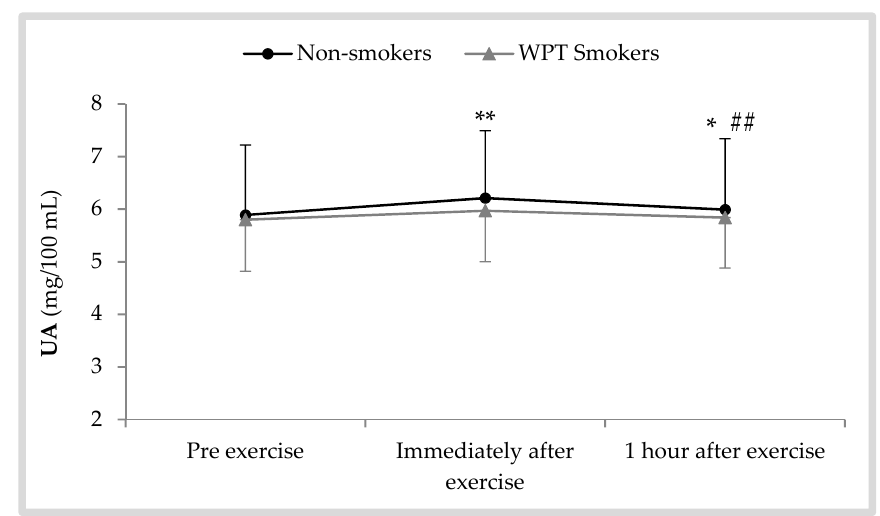
Figure 4. Salivary uric acid (UA) concentrations following a bout of exhaustive aerobic exercise in WPT smokers and non-smokers; * p < 0.05 vs. pre, ** p < 0.01 vs. pre, ## p < 0.01 vs. immediately after.